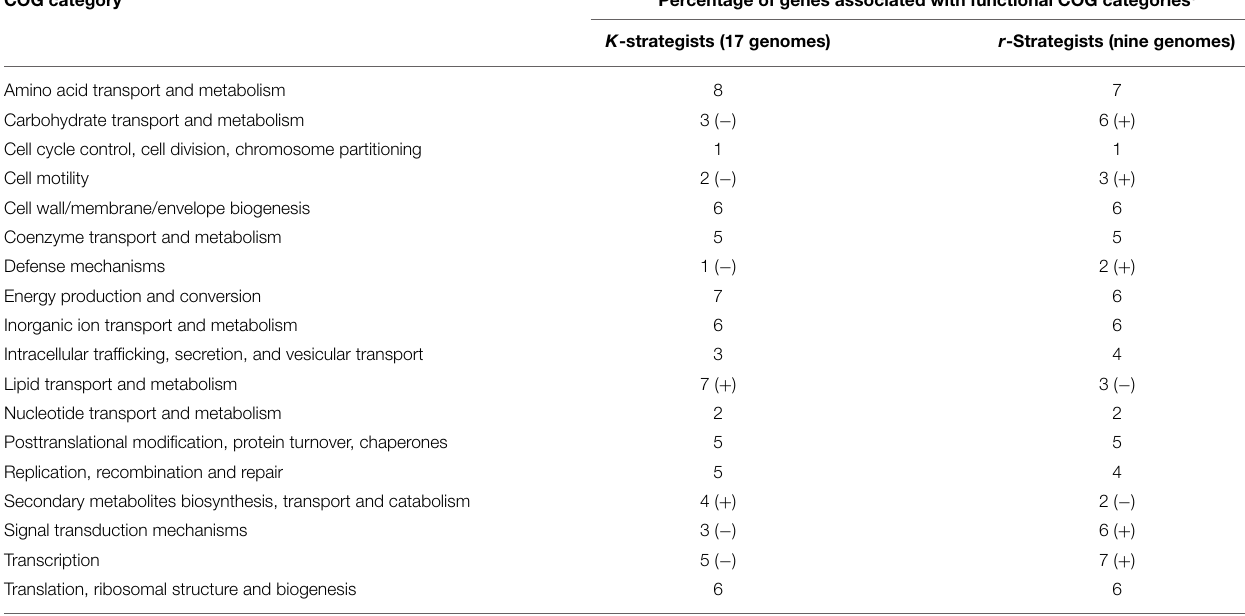
TABLE 3 | Abundance of genes associated with functional COG categories in genome sequenced members of two guilds of the novel order Cellvibrionales that are distinguishable by their trophic strategy. COG category Percentage of genes associated with functional COG categories a K -strategists (17 genomes) r -Strategists (nine genomes) Amino acid transport and metabolism 8 Carbohydrate transport and